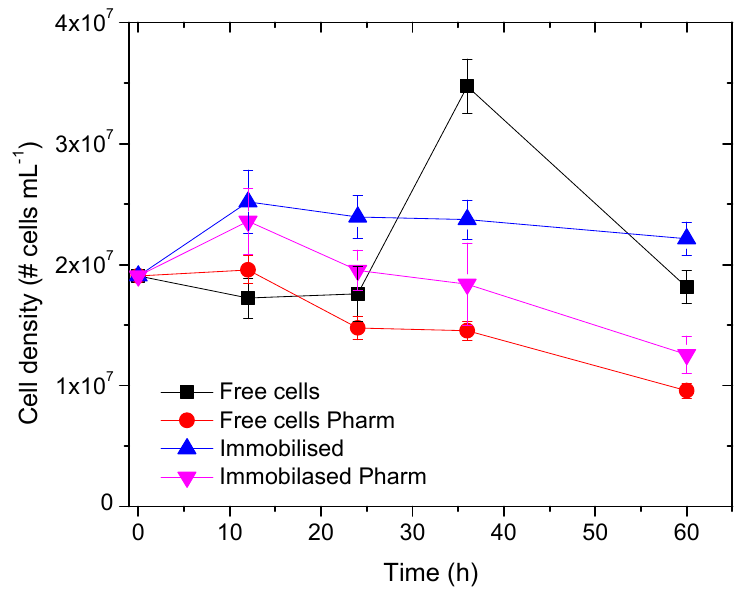
Figure 5. Growth curve of Nannochloropsis sp. in continuous cultures for 60 h. Error bars represent SD. The lines are guides for the eyes.